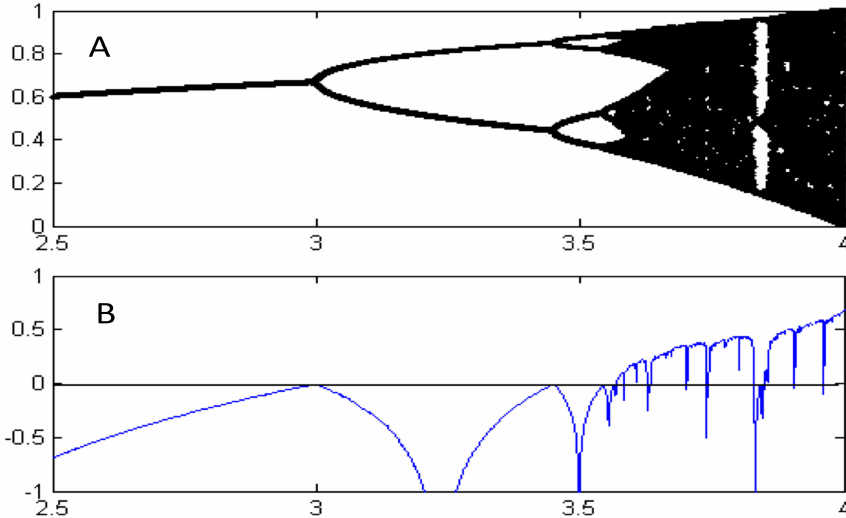
Figure 1. A . Bifurcation diagram showing the set of values of the logistic function visited asymptotically at di ff erent values of the bifurcation parameter µ . B . The corresponding Lyapunov exponent, which is often used for quantifying the sensitivity of a system to initial conditions [12]. A positive sign of the exponent signifies chaos and its value measures its quantity. Note that the chaotic regimes in A correspond to positive Lyapunov exponent values in